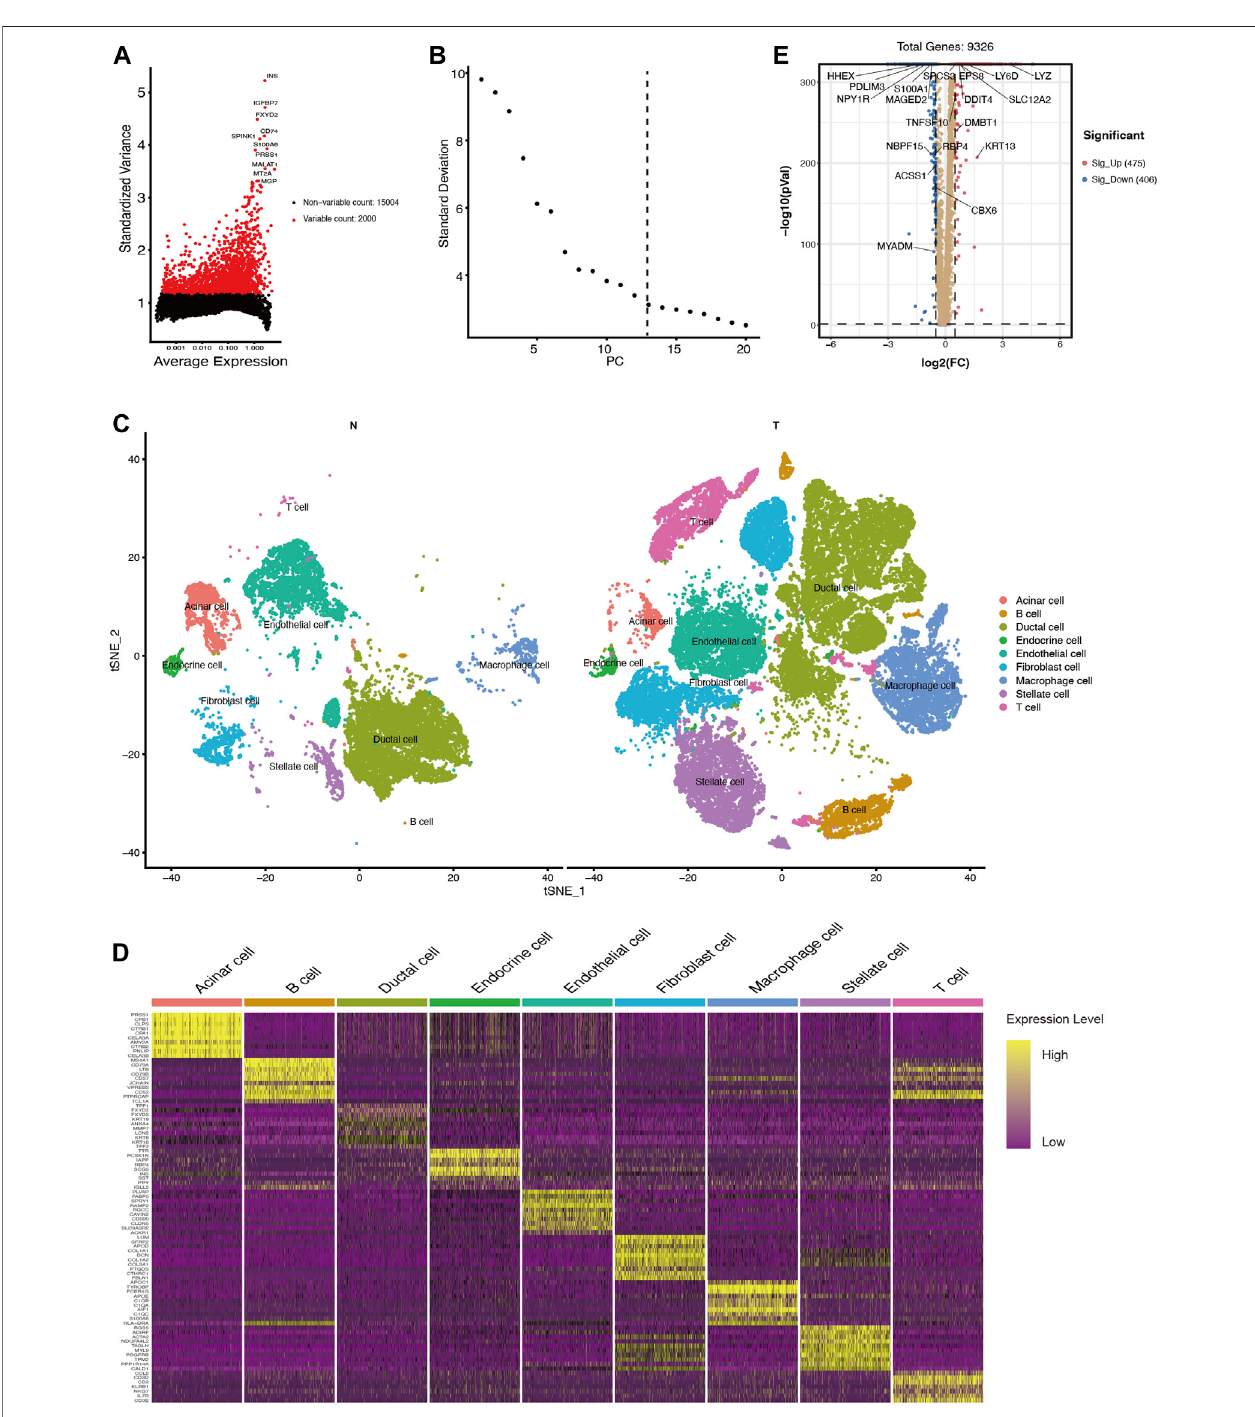
FIGURE1| scRNA-seqidenti fi es9celltypesinthePDACtissuesand881differentiallyexpressed genesbetweenductalcellsinnormalandtumortissues. (A) The top2000variablegeneswithlarge,standardizedvariancesforsubsequentanalysis. (B) Theelbowplotshows13PCsappropriateforfurthercellclusterclassi fi cation (C) tSNEalgorithmclassi fi edcellclustersbasedontranscriptomedata. (D) Heatmapoftop10markergenesforeachcellcluster. (E) Differentiallyexpressedgenesbetween ductal cells in normal and tumor tissues. T, tumor; N, normal.